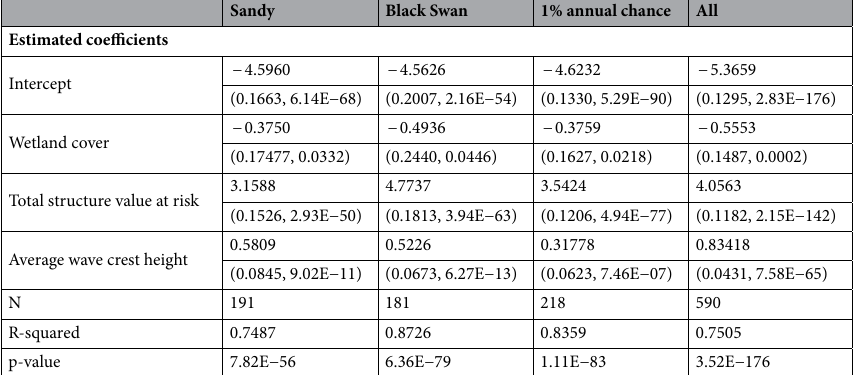
Sandy Black Swan 1% annual chance